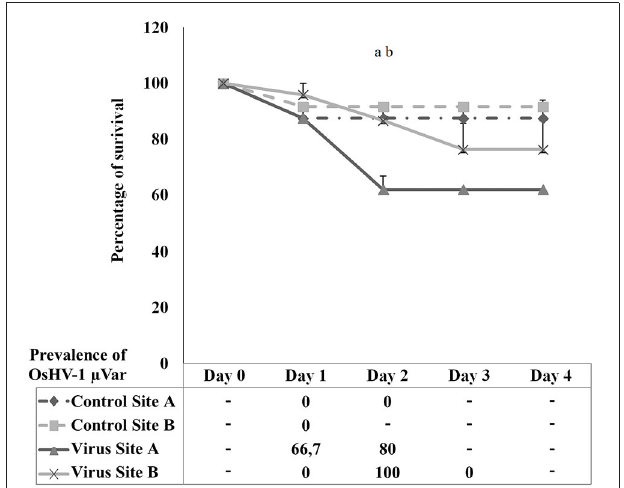
FIGURE 7 | Percentage of survival in spat oysters injected with OsHV-1 µ Var (virus) and sea water (control) collected at Site A and Site B. Table below the graph shows the prevalence of infection in dead animals collected at each sampling point. (a) Significant differences between control and virus at Site A. (b) Significant differences between Site A and Site B in virus exposed animals ( n = 2, p ≤ 0.05).